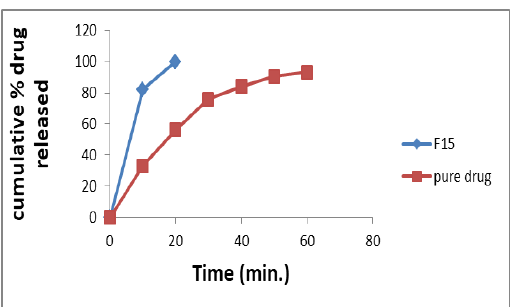
Figure 2. Dissolution profile of mirtazapine (F15) nanosuspension and pure drug in 0.1N HCl (pH 1.2) at 37  C Drug content in lyophilized powder The drug content result of lyophilized powder of the selected formula (F 15) 97.64% of mirtazapine when determined by UV-visible spectrophotometer at λmax 315 nm . Evaluation of mirtazapine nanoparticles powder Powder flowability Angle of repose and compressibility index of the powder of the formulas (F15a and F15b) were reported in Table (6).